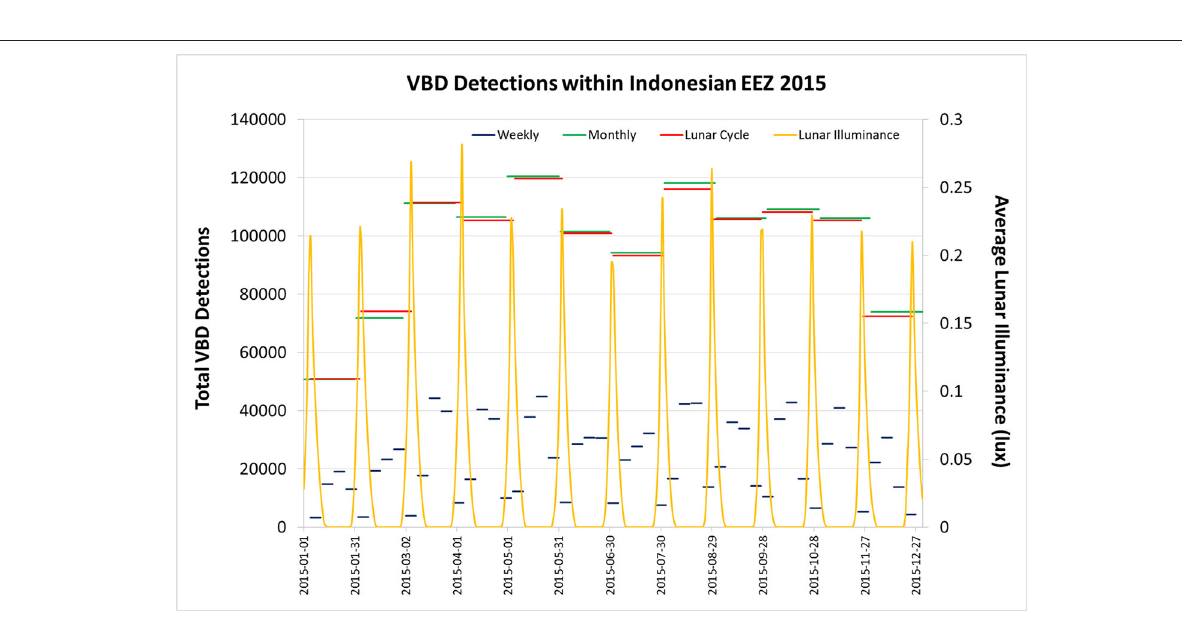
Binh (44%) provinces. The VCI ran negative in 2 months each for Ha Tinh and Quang Tri provinces. Despite the four negative VCI samples, the VCI mean during the closure months is 18%. The mean VCI from the pre-closure period is 3.6%. Statistical testing indicates that the mean VCI during the closure period is larger than the pre-closure value ( Table 3 ). This indicates that compliance was detected by the VCI, but that the compliance rates were modest, under 40% in nearly every